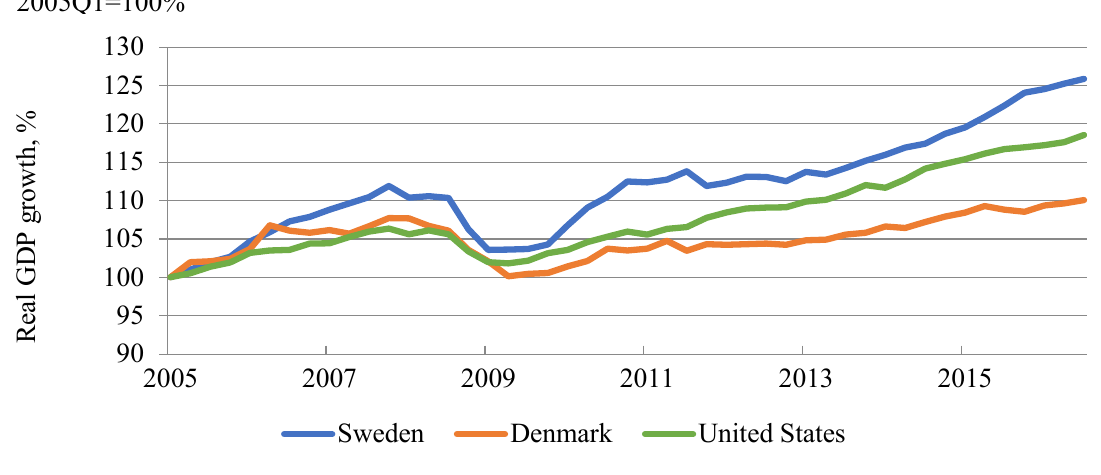
Figure 2. Real GDP in Sweden, Denmark, and the United